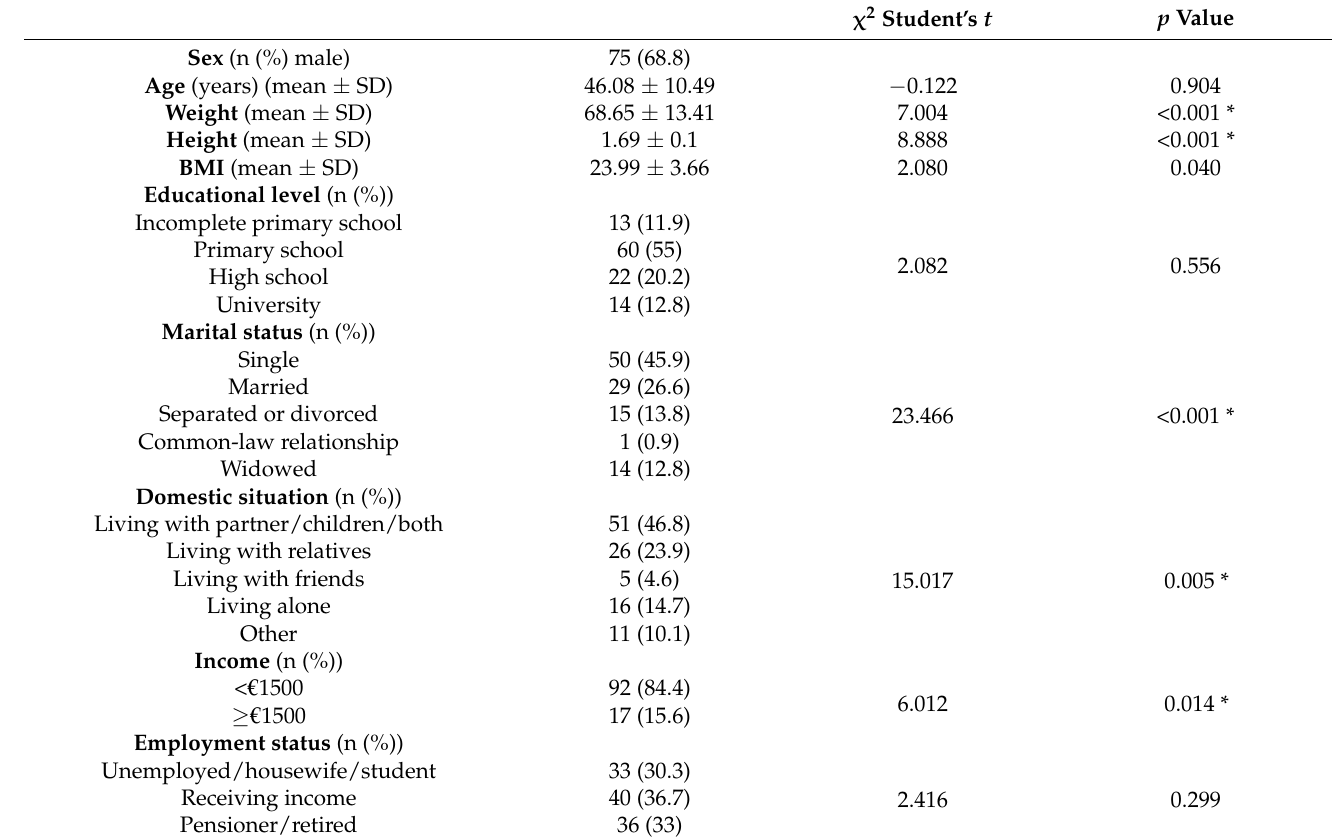
Table 1. Sociodemographic, epidemiological and clinical characteristics of the